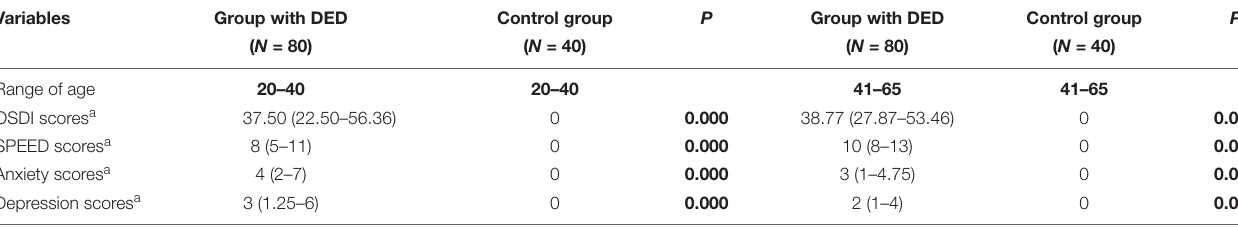
TABLE 3 | Dry eye symptoms and psychological disturbances.